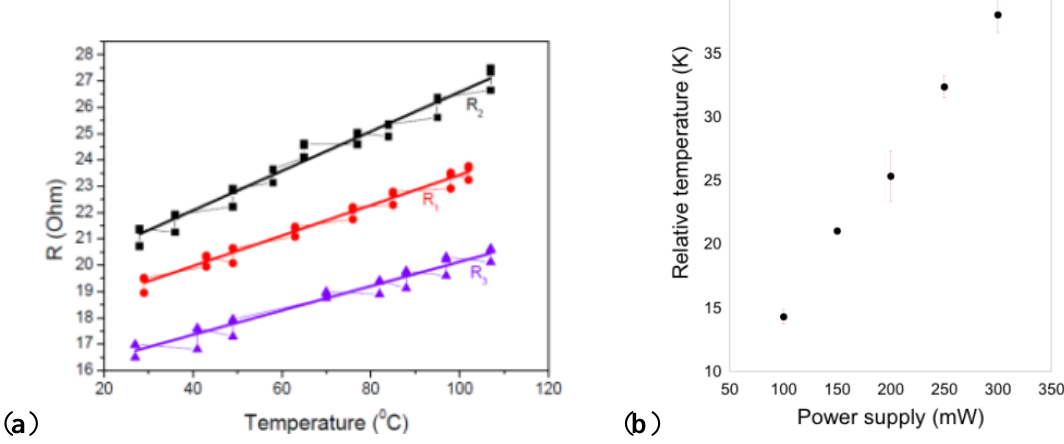
Figure 8. ( a ) Calibration curves: plot of the resistance R versus temperature T for the three microheaters. Reprinted from [42], Copyright 2011, with permission from